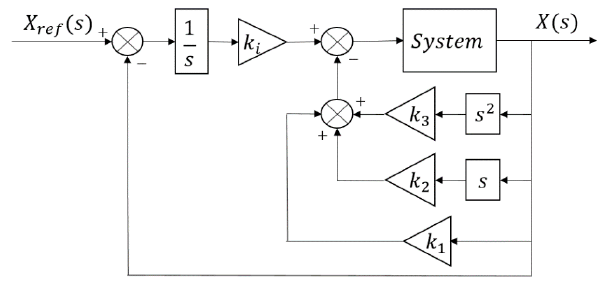
Figure 5. Block diagram of the state feedback controller with integral action (SFCI) controller.